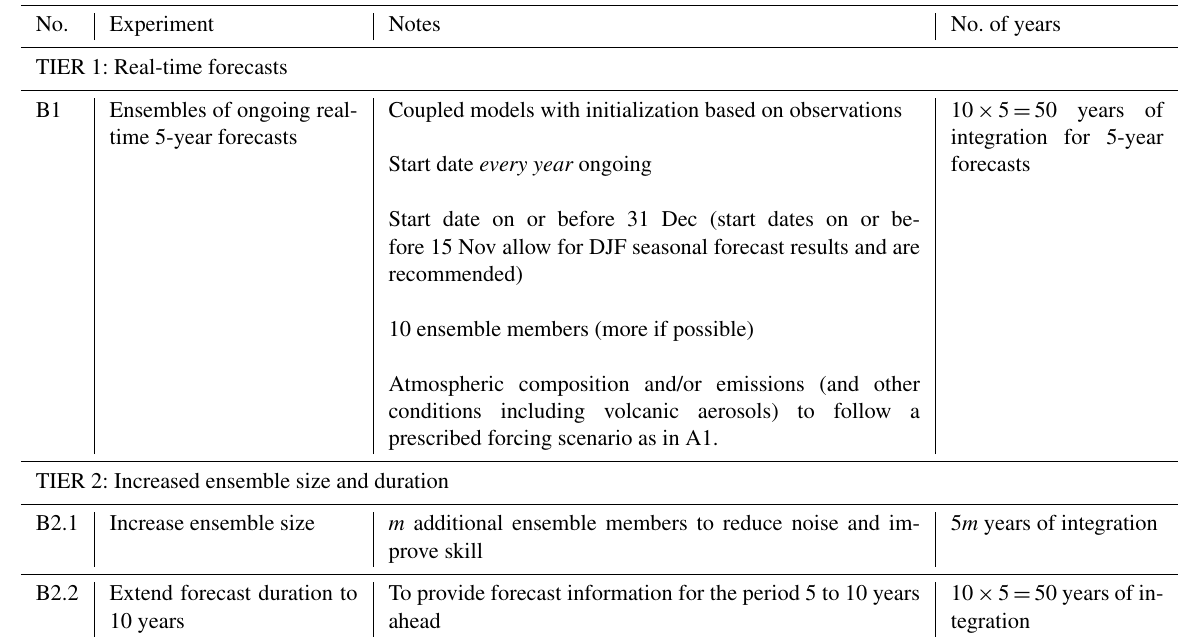
Table B1. Real-time decadal